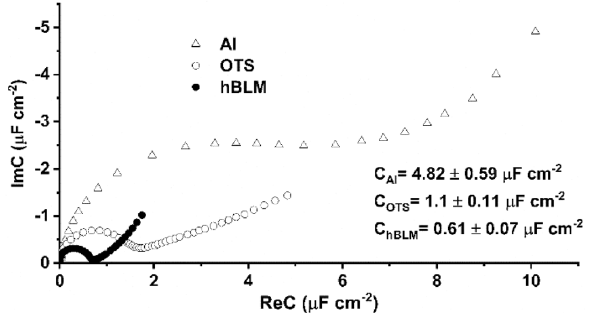
Figure 3. Electrochemical impedance spectra in Cole–Cole plot of Al, OTS and DOPC:Chol (molar % ratio 6:4) hBLM, formed by vesicle fusion method after 30 min incubation time. The applied potential: − 0.7 V versus